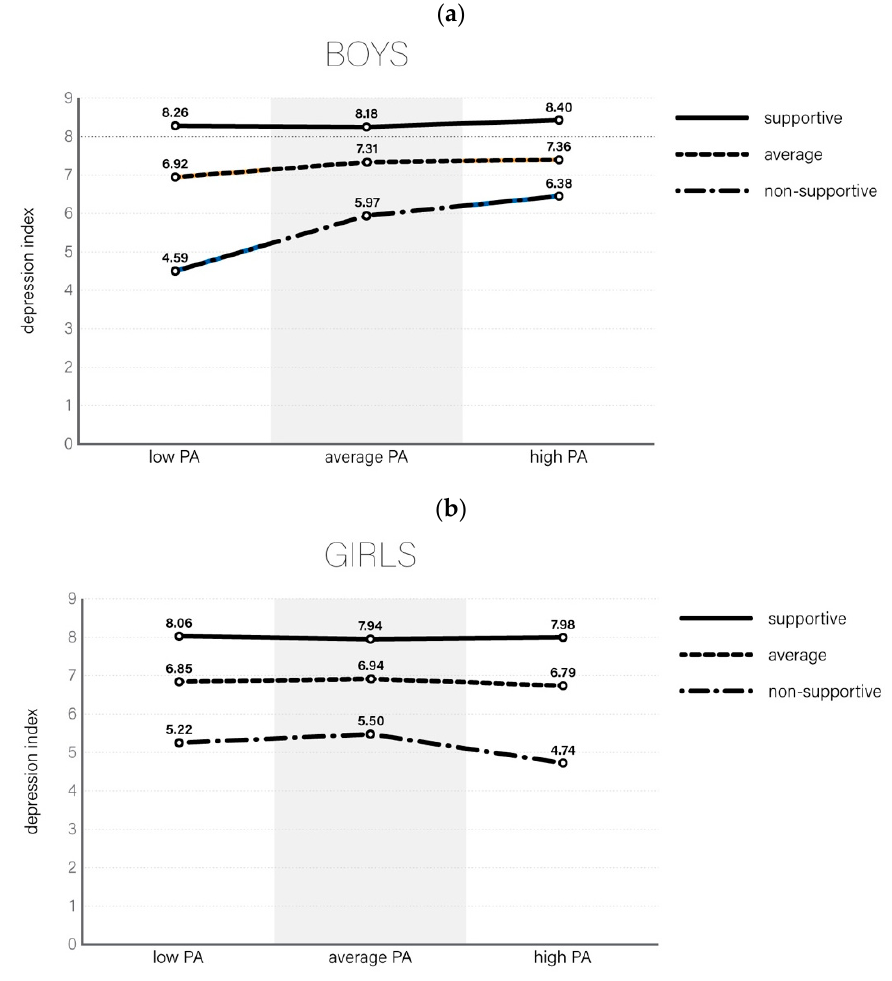
Figure 1. ( a ) Life satisfaction (Cantril index) among boys according to physical activity and growing- up environment; ( b ) Life satisfaction (Cantril index) among girls according to physical activity and growing-up environment.